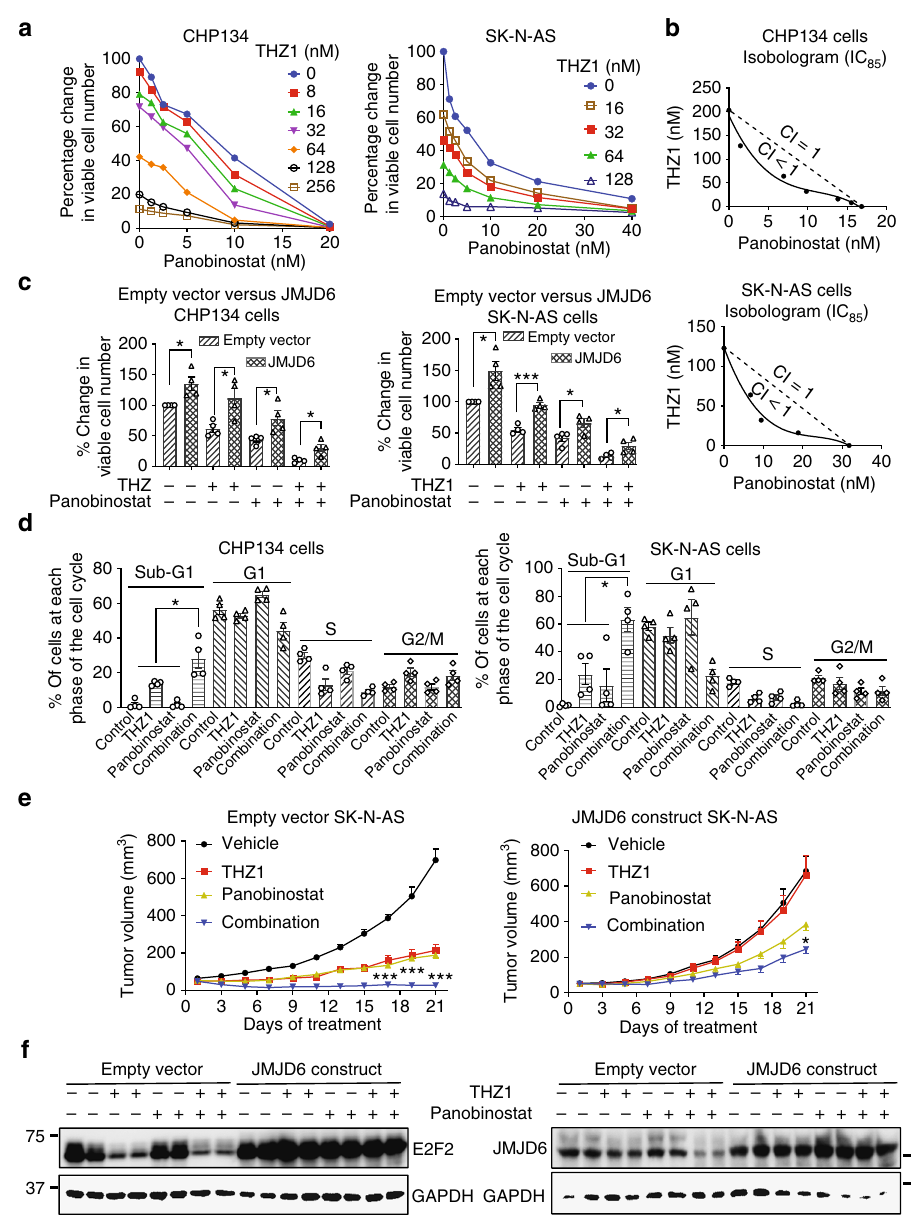
Fig. 7 THZ1 and panobinostat synergistically induce tumor regression by reducing JMJD6. a , b CHP134 and SK-N-AS cells were treated with vehicle control, THZ1, panobinostat, or their combination for 72 h, followed by Alamar blue assays ( a ). Error bars represent normalized standard errors from three independent experiments. Isobolograms showed the actual concentrations of THZ1 and panobinostat required to achieve inhibition of cell viability by 85% (IC 85 , solid line), as compared with additivity [dotted line, combination index (CI) = 1] ( b ). c CHP134 and SK-N-AS cells stably transfected with an empty vector or JMJD6 expression construct were treated with vehicle control, 32 nM THZ1, 10 nM panobinostat, or their combination for 72 h, followed by Alamar blue assays. Error bars represent normalized standard errors from four independent experiments (* p < 0.05, *** p < 0.001, two-tailed unpaired Student ’ s t test). d CHP134 and SK-N-AS cells were treated with vehicle control, 32 nM THZ1, 10 nM panobinostat, or their combination for 72 h, followed by staining with propidium iodide and fl ow cytometry analysis of the cell cycle. Error bars represent standard errors from four independent experiments (* p < 0.05, two-tailed unpaired Student ’ s t test). e Seventy-two nude mice were xenografted with SK-N-AS cells stably transfected with an empty vector or JMJD6 ORF expression construct. When tumors reached 0.05 mm 3 , the mice were divided into four subgroups of nice mice each and treated intraperitoneally with control solvent, THZ1 (10 mg/kg body weight/twice a day), panobinostat (7.5 mg/kg body weight/3 days), or THZ1 plus panobinostat for 21 days. Tumor mass was measured every other day. Error bars represent standard errors (* p < 0.05, *** p < 0.001, two-way ANOVA). f Protein was extracted from the tumor tissues, and subjected to immunoblot analysis of JMJD6 and E2F2 protein expression. Source data are provided as a Source Data fi